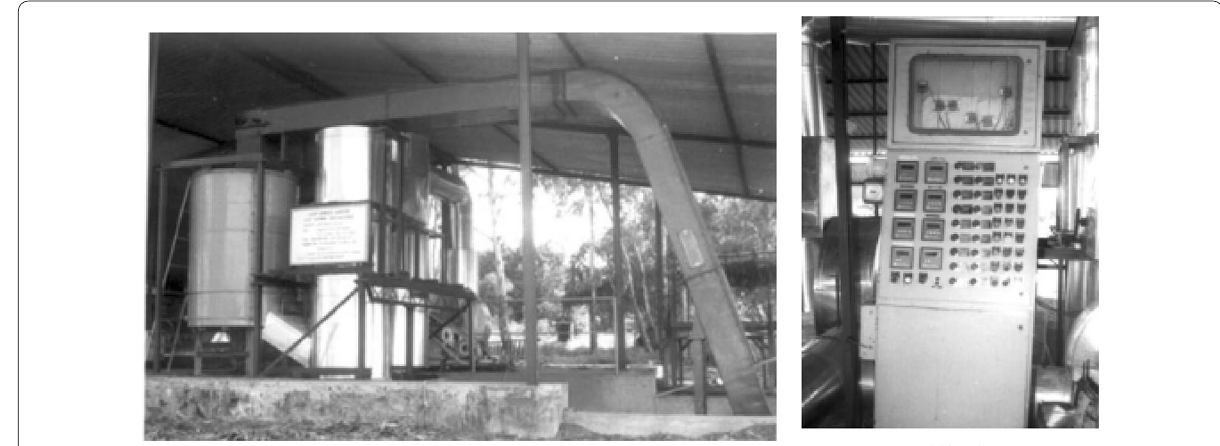
Fig. 4 The SCB gasifier designed by Jorapur and Rajvanshi (1997)